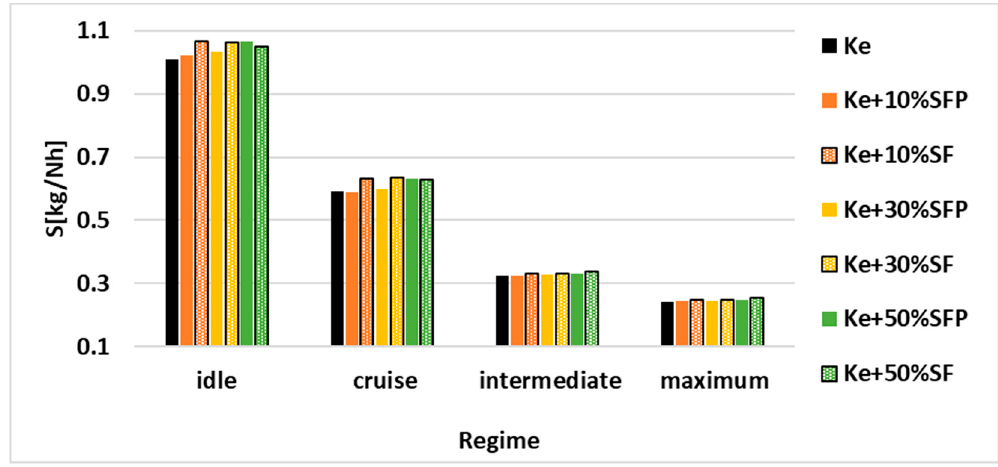
Figure 13. Variation of specific consumption for all four regimes and for all the tested fuel blends.